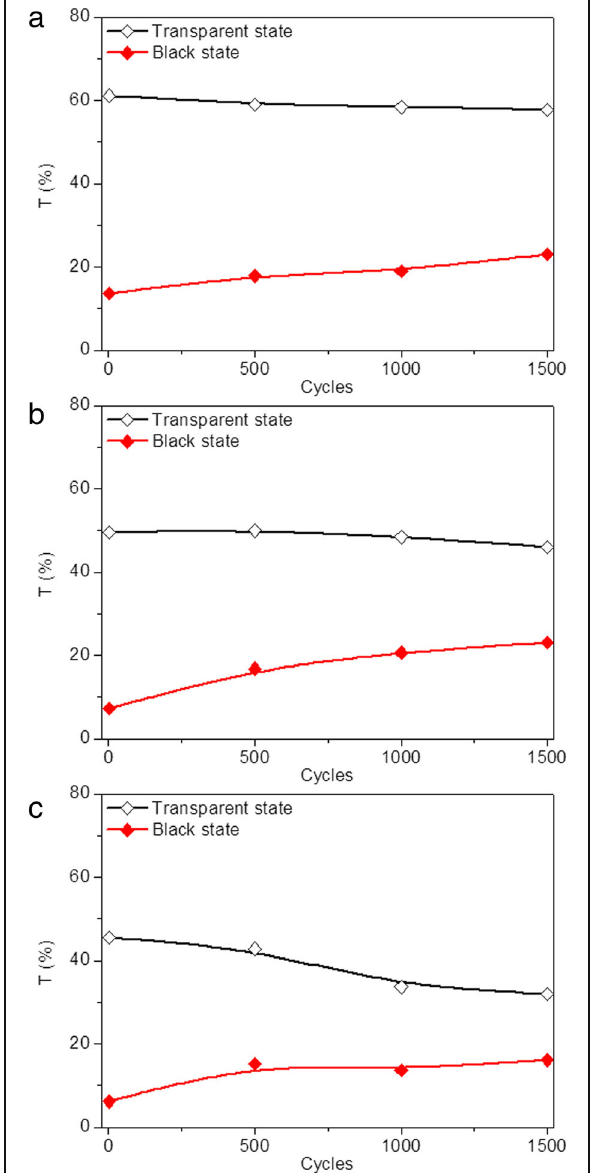
Fig. 5 (Color online) Transmittance variation for dip-coated